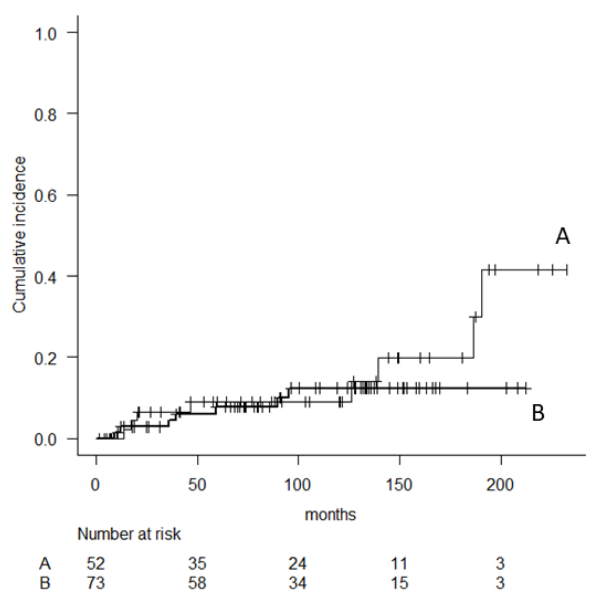
Figure 5. Cumulative risk analysis of implant failure due to aseptic loosening comparing patients with cement ( A ) and cementless ( B ) femoral stem.